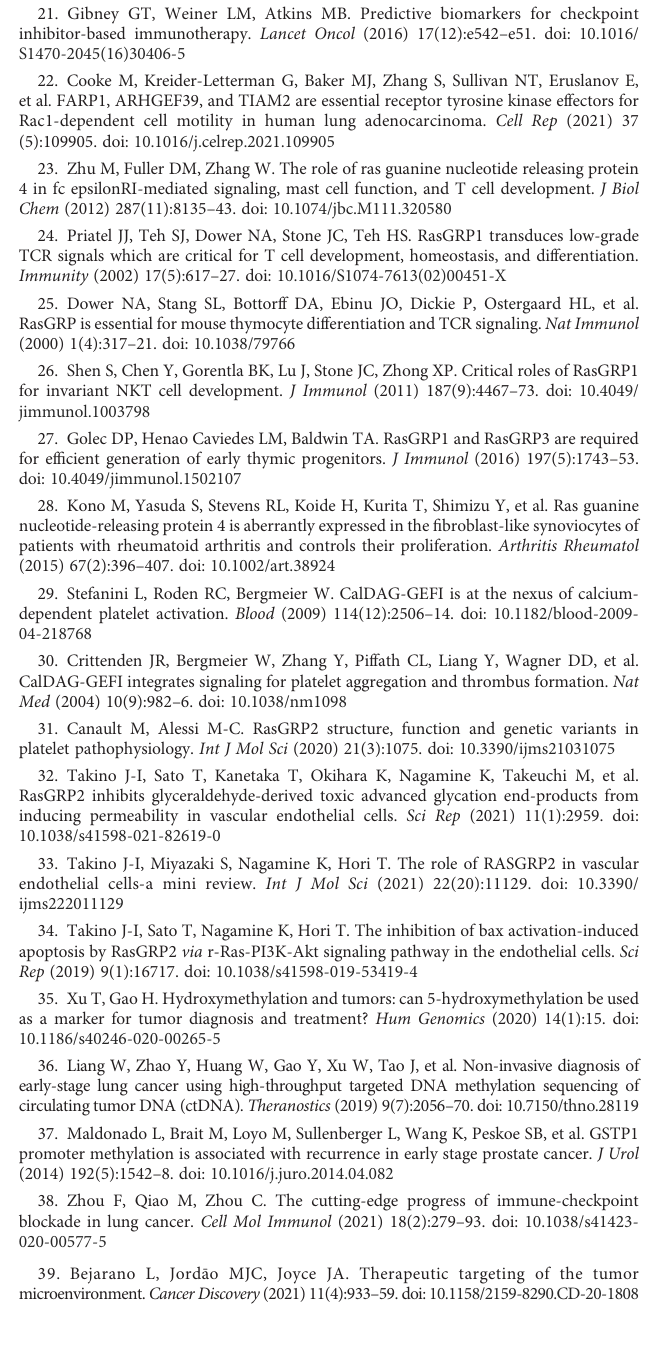
SUPPLEMENTARY TABLE 1 Clinicopathological parameters of real-world LUAD cohort from Xiangya Hospital. SUPPLEMENTARY TABLE 2 Guanine nucleotide exchange factors (GEFs) from GeneCards. SUPPLEMENTARY TABLE 3 Predictive transcription factor in CHEA. SUPPLEMENTARY TABLE 4 Predictive transcription factor in